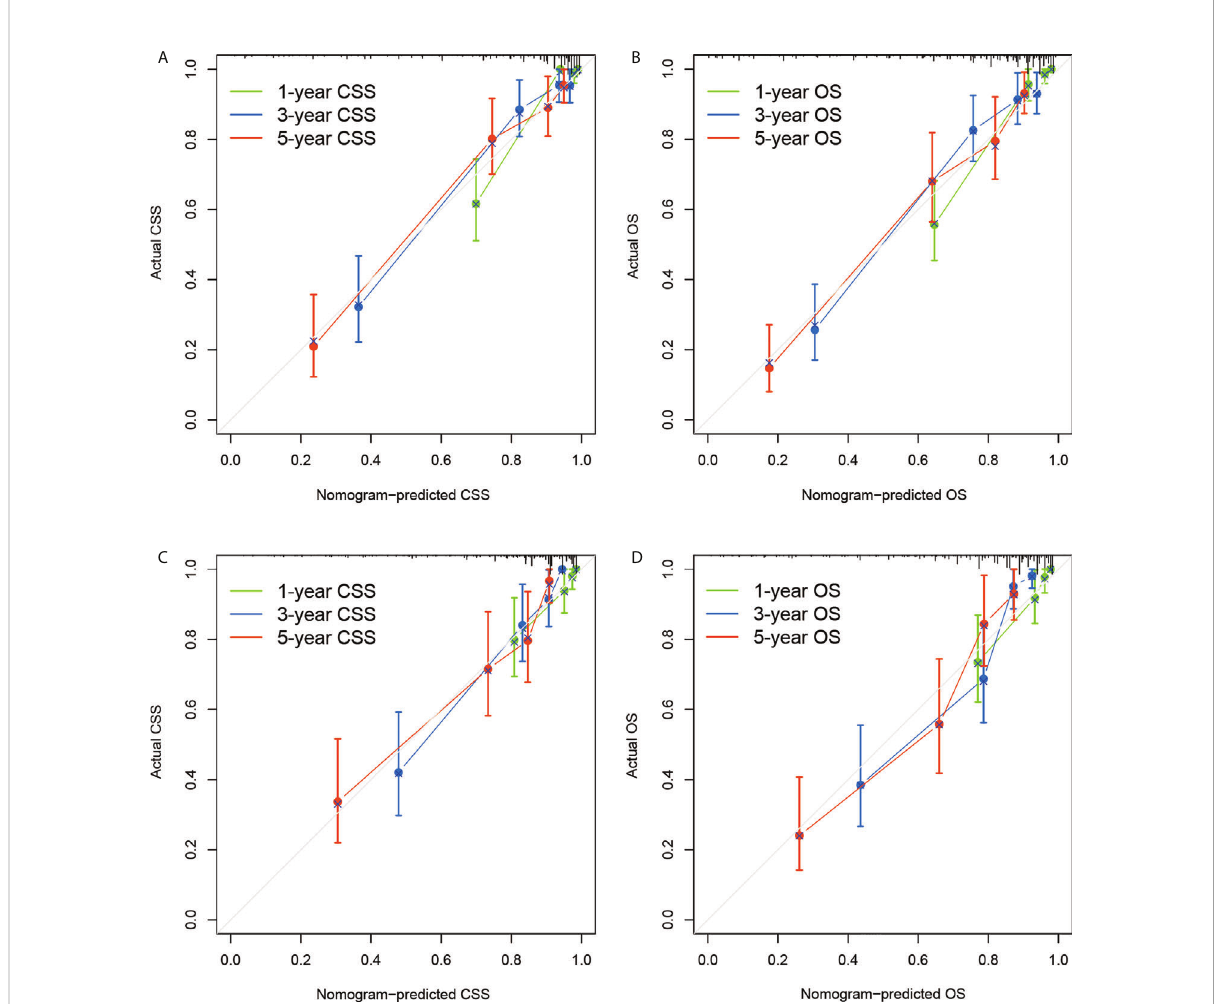
FIGURE 3 Calibration plots of the nomograms to predict CSS and OS of the derivation dataset (A, B) and external validation dataset (C, D) . CSS, lung cancer-speci fi c survival; OS, overall